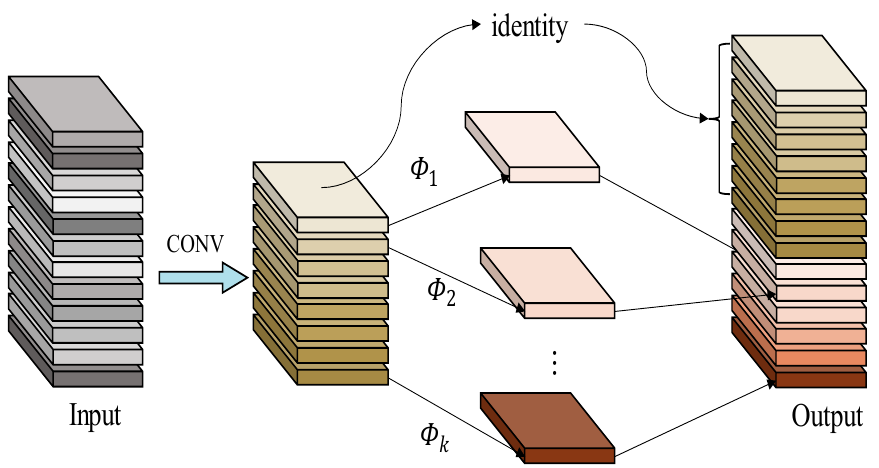
Figure 2. Ghost module structure description.